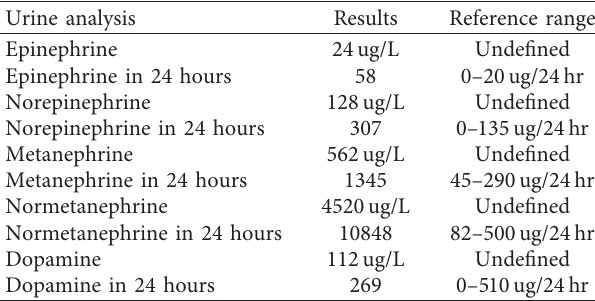
Figure 1: T2-Weighted MRI of the abdomen: slight increased T2 signal and heterogeneous enhancement of the right adrenal gland (arrows). Table 1: Urine analysis.